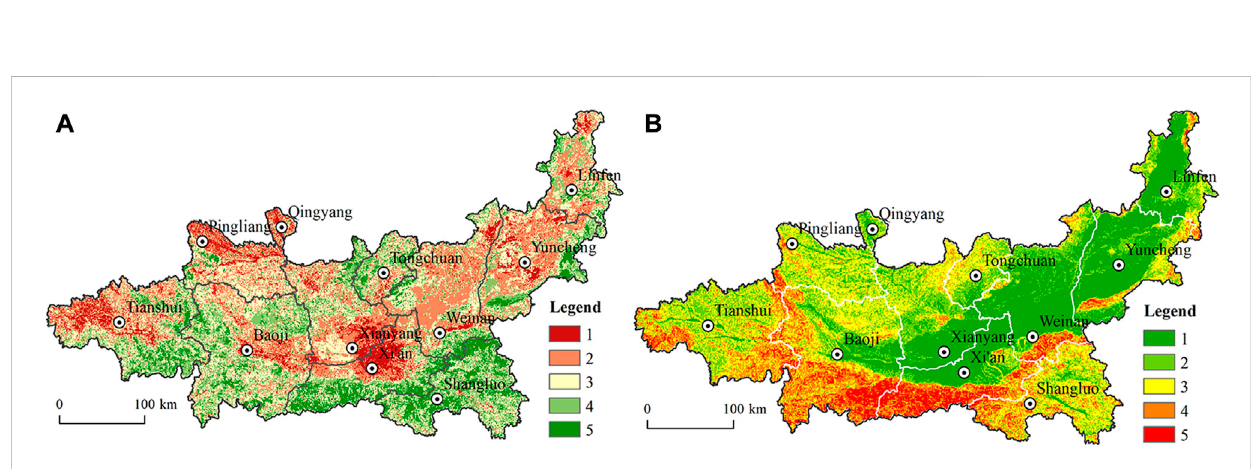
FIGURE 5 Spatial distribution of ecosystem services importance grades (A) and eco-environmental sensitivity grades (B) in GPUA (Grade 1 = minimal importance/sensitivity; Grade 5 = highest importance/sensitivity; 1 to fi ve refer to slight, mild, moderate, strong, extremely